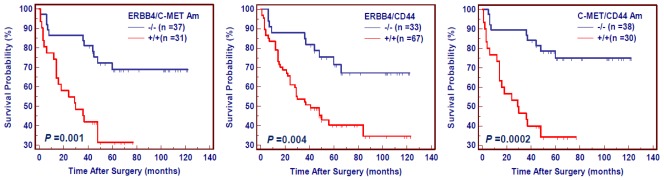
The effect of concomitant amplification of two of three genes on poor survival in gastric cancer. Survival was evaluated according to the presence of concomitant amplification of two of three genes in a number of gastric cancer patients without residual tumor after surgery. The patients with gene amplification had significantly shorter survival times than the patients without gene amplification. +/+, harboring concomitant amplification of two genes; −/−, the lack of gene amplification.